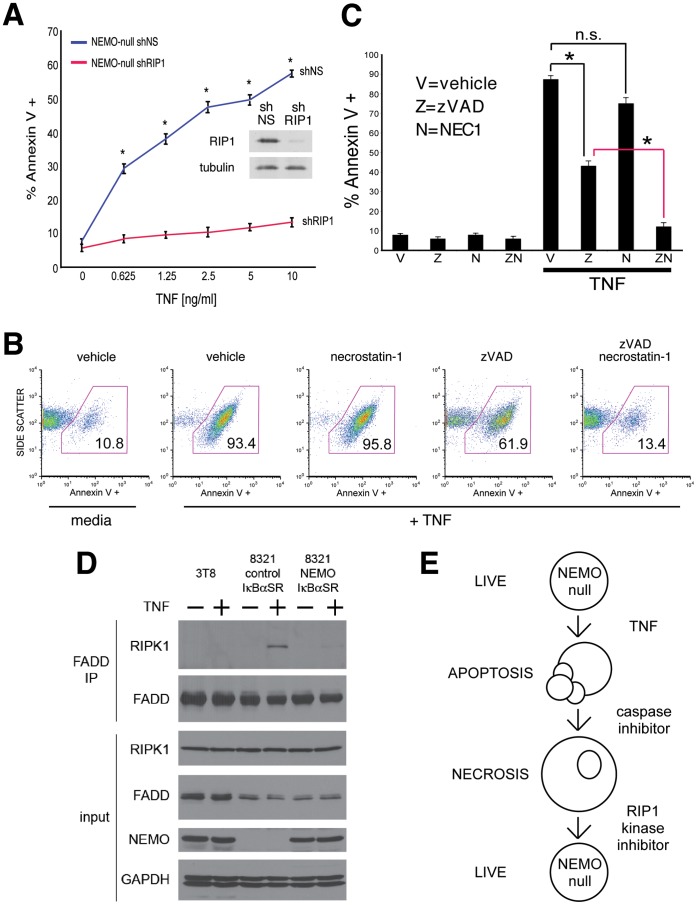
NEMO-deficient cells undergo RIP1 kinase-dependent programmed necrosis.(A) 8321 NEMO-null cells transduced with retrovirus encoding non-targeting (shNS) or RIP1-targeting short hairpins (shRIP1) were co-incubated with 10 µM zVAD caspase inhibitor and different doses of TNF for 24 h. Cell death was quantified by Annexin V staining and flow cytometry. The mean and SEM of three independent experiments is shown, * denotes p<0.05. Immunoblot indicates efficient knockdown of RIP1 protein in shRIP1 cells. Data shown is representative of similar results obtained with two different RIP1-targeting hairpins. (B) 8321 NEMO-null cells were pre-treated for one hour with 10 µM zVAD and/or 30 µM Necrostatin-1 as indicated, and then stimulated with 10 ng/ml TNF for 24 hours. Cell death was quantified as described in (A). The number inside the polygon gate indicates the percentage of cells that stain with Annexin V. (C) The bar chart displays the mean percentage and SEM from three independent experiments of Annexin V staining cells after 24 h of culture in vehicle, zVAD, Necrostatin-1 or a combination of zVAD and Necrostatin-1 either in the presence or absence of 10 ng/ml TNF for 24 h, * denotes p<0.05. (D) The parental NEMO-sufficient cell line 3T8 and NEMO-deficient 8321 cells transduced with the IκBαSR and reconstituted with either a control protein or NEMO-WT were treated with 10 µM zVAD and then stimulated with 10 ng/ml TNF for 10 hours. The necrosome was isolated by immunoprecipitation with anti-FADD and then immunoblottted for RIP1. A sample of the lysate was blotted for RIP1, NEMO, FADD and GAPDH as a loading control. (E) These data demonstrate that NEMO-null cells preferentially undergo apoptosis and caspase blockade is required for entry into RIP1 kinase-dependent programmed necrosis, which is summarized in the cartoon.